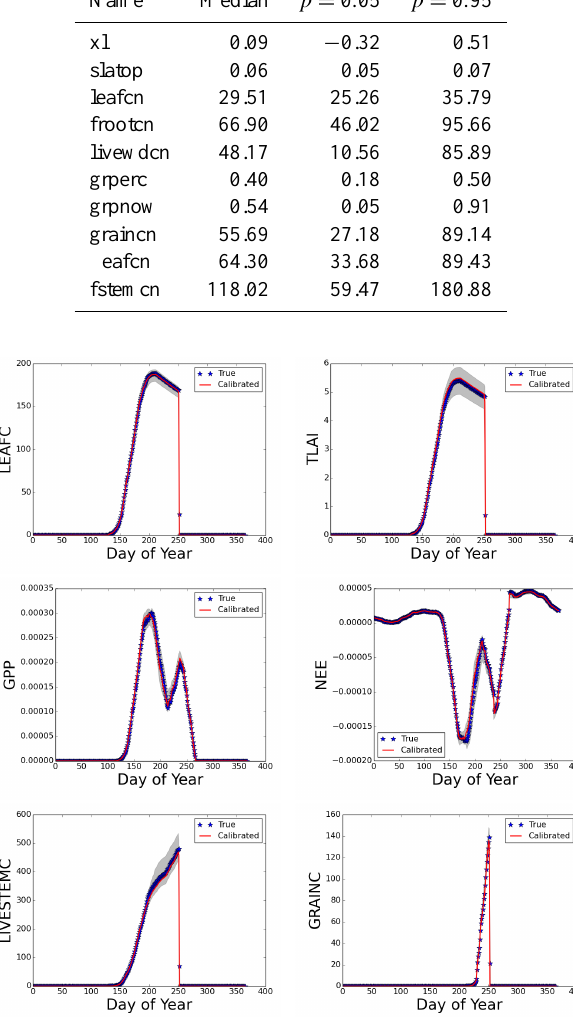
Figure 2. Twin experiment: comparison of the posterior with the prior. The red dot indicates the true parameter value. The figure is continued on the next page.